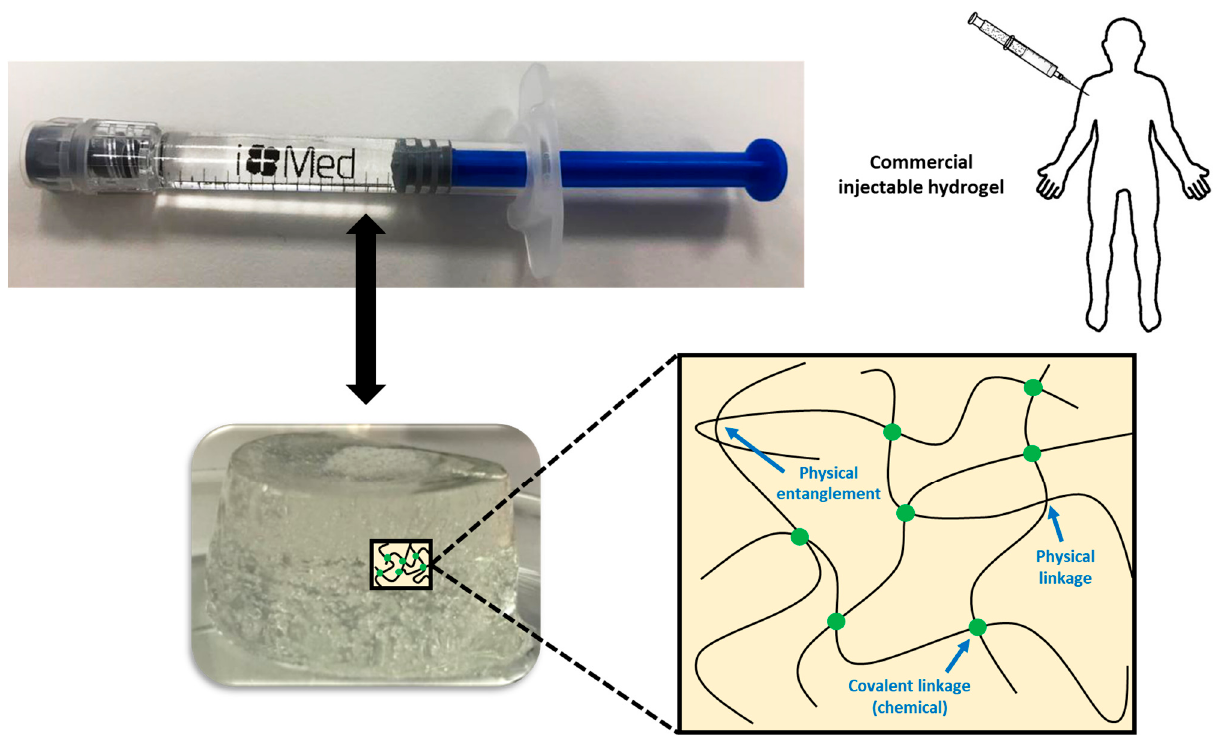
Figure 1. Physical interactions and chemical linkages of the chemical structure of an injectable hydrogel. It is also possible to avoid the need for purification by using water-soluble polymers such as many polysaccharides. However, sometimes, they also need some kind of crosslink- ing agent, and the need to purify unreacted molecules of it comes back again. Among them, the most common glycosaminoglycan found in many living tissues is hyaluronic acid (HA) or hyaluronan. HA is a linear glycosaminoglycan made up of repeating